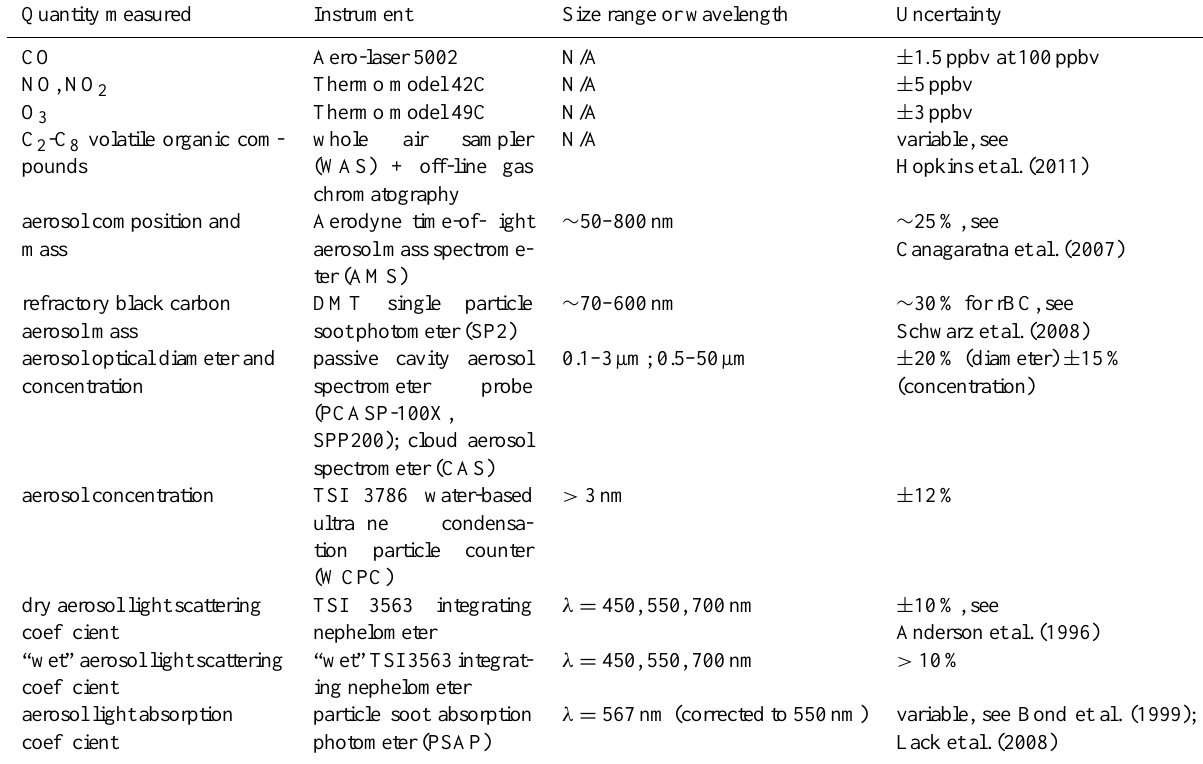
Table 2. Summary of in situ trace gas and aerosol sampling instrumentation on the FAAM BAe-146 during the EM25 campaign. Quantity